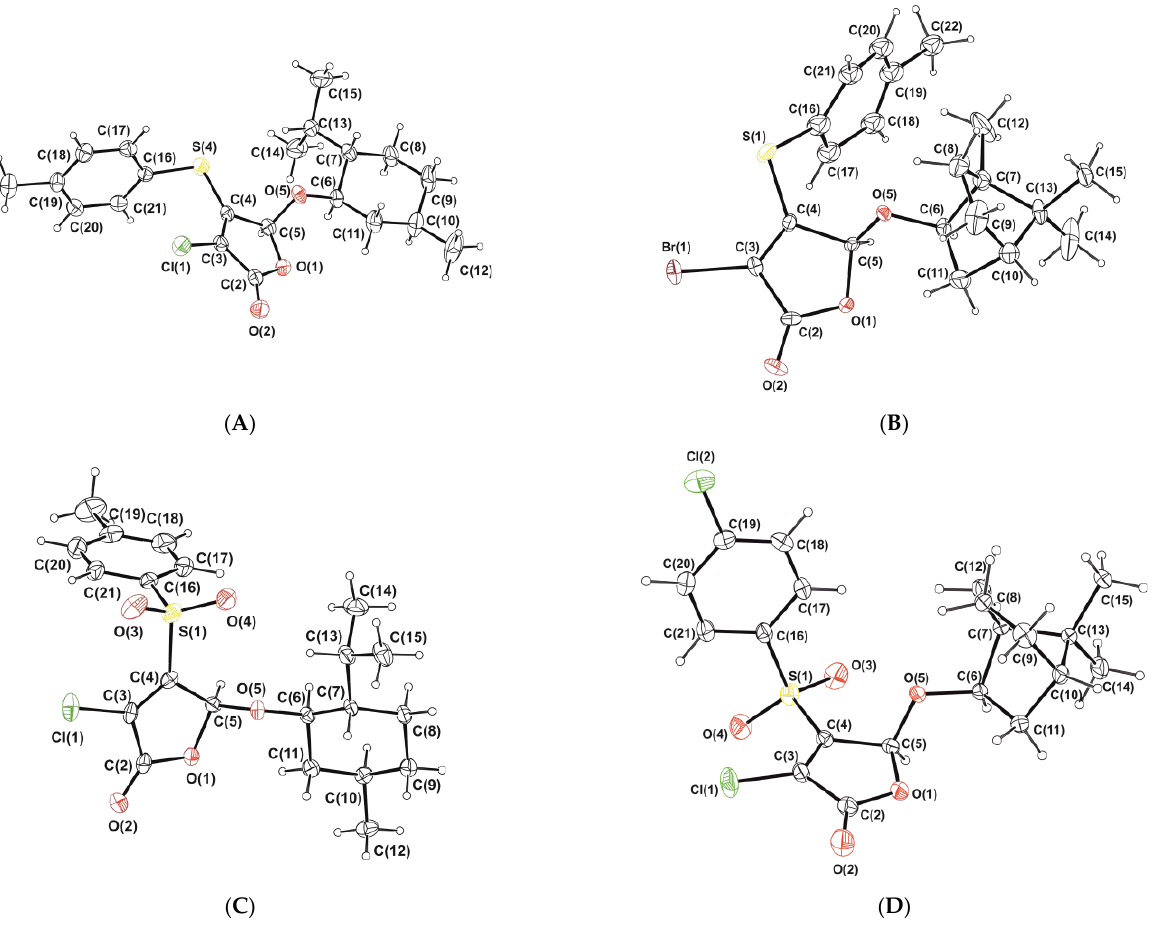
Figure 3. Molecular structure of thioethers 7 ( A ) and 16 ( B ), and sulfones 19 ( C ) and 26 ( D ) in the crystal.